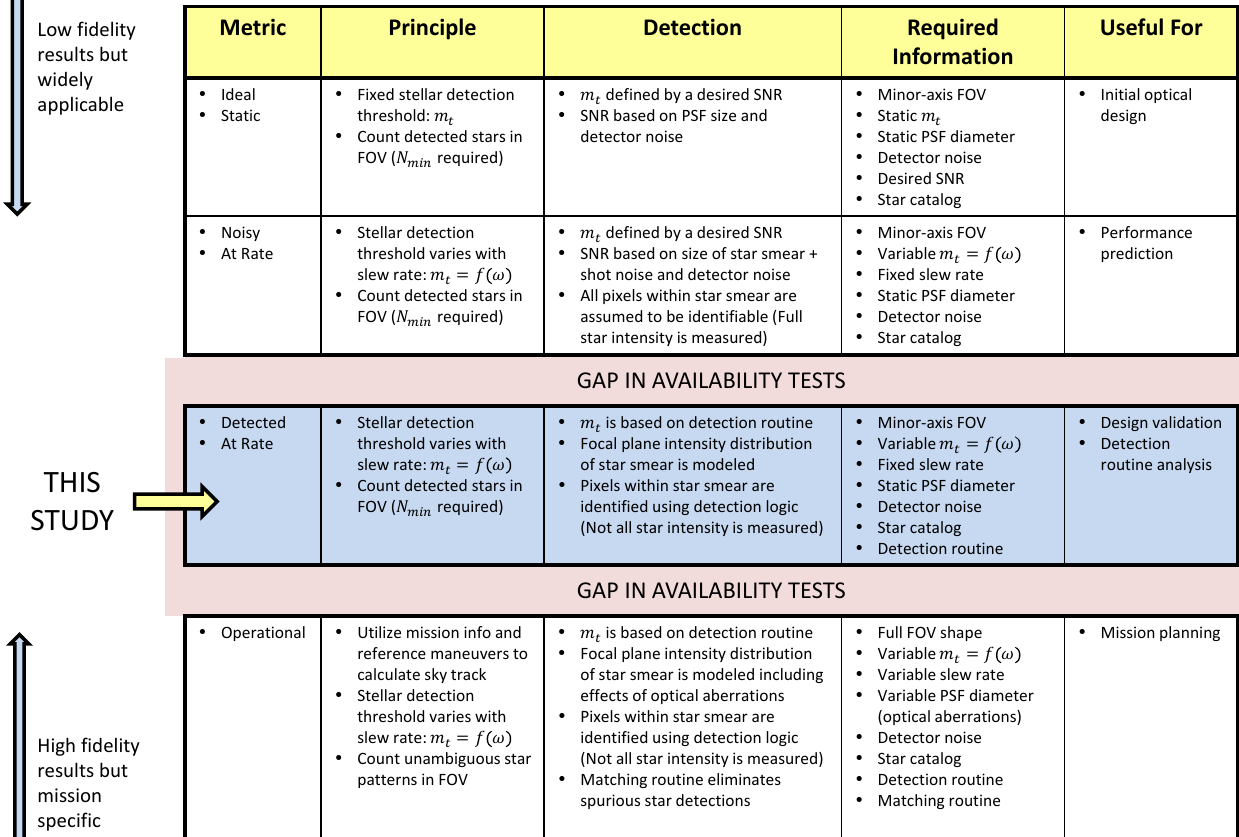
Figure 1. Commonly used types of availability